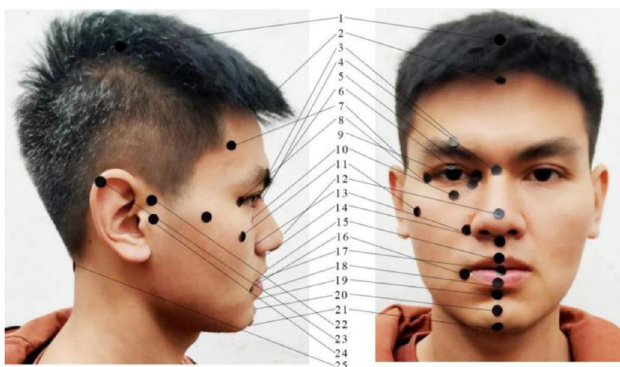
Fig. 2. Determination of the 25 head-feature points. 1, Vertex;